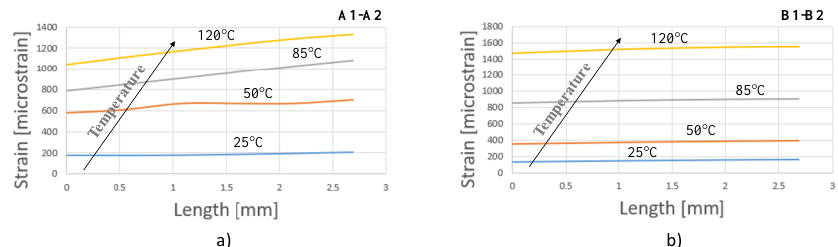
Figure 13. The variation in strain obtained by FEA vs. temperature: ( a ) A1 – A2; ( b ) B1 – B2.